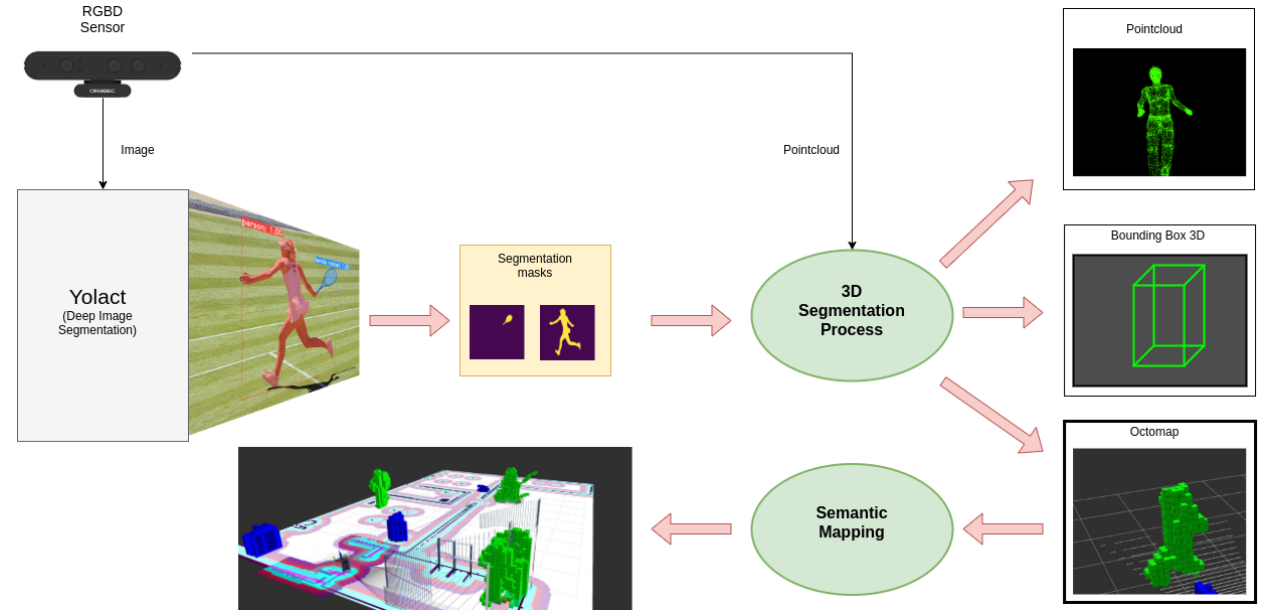
Figure 2. Complete process of our approach.